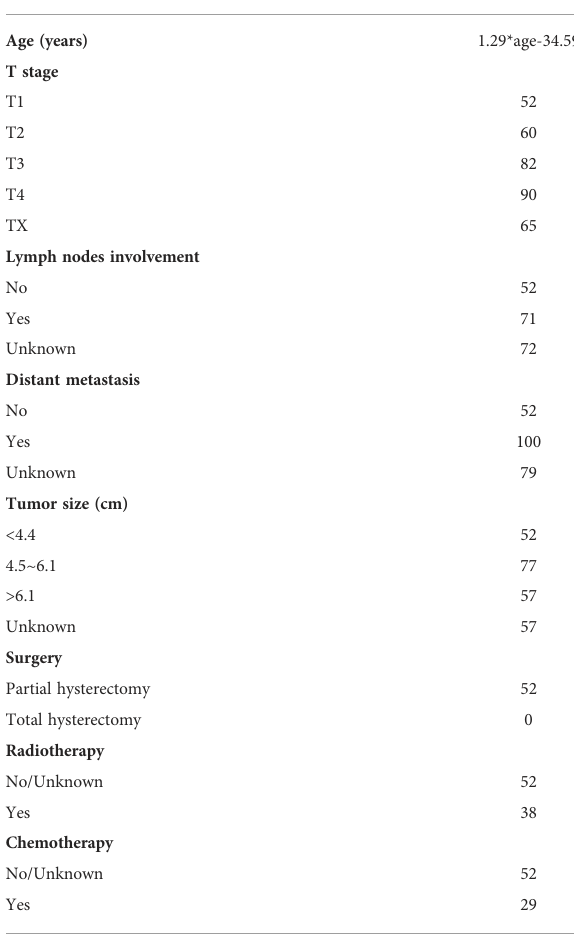
TABLE 5 Nomogram scores of each independent prognostic factor in the FIGO stage III/IV ECCC patients.